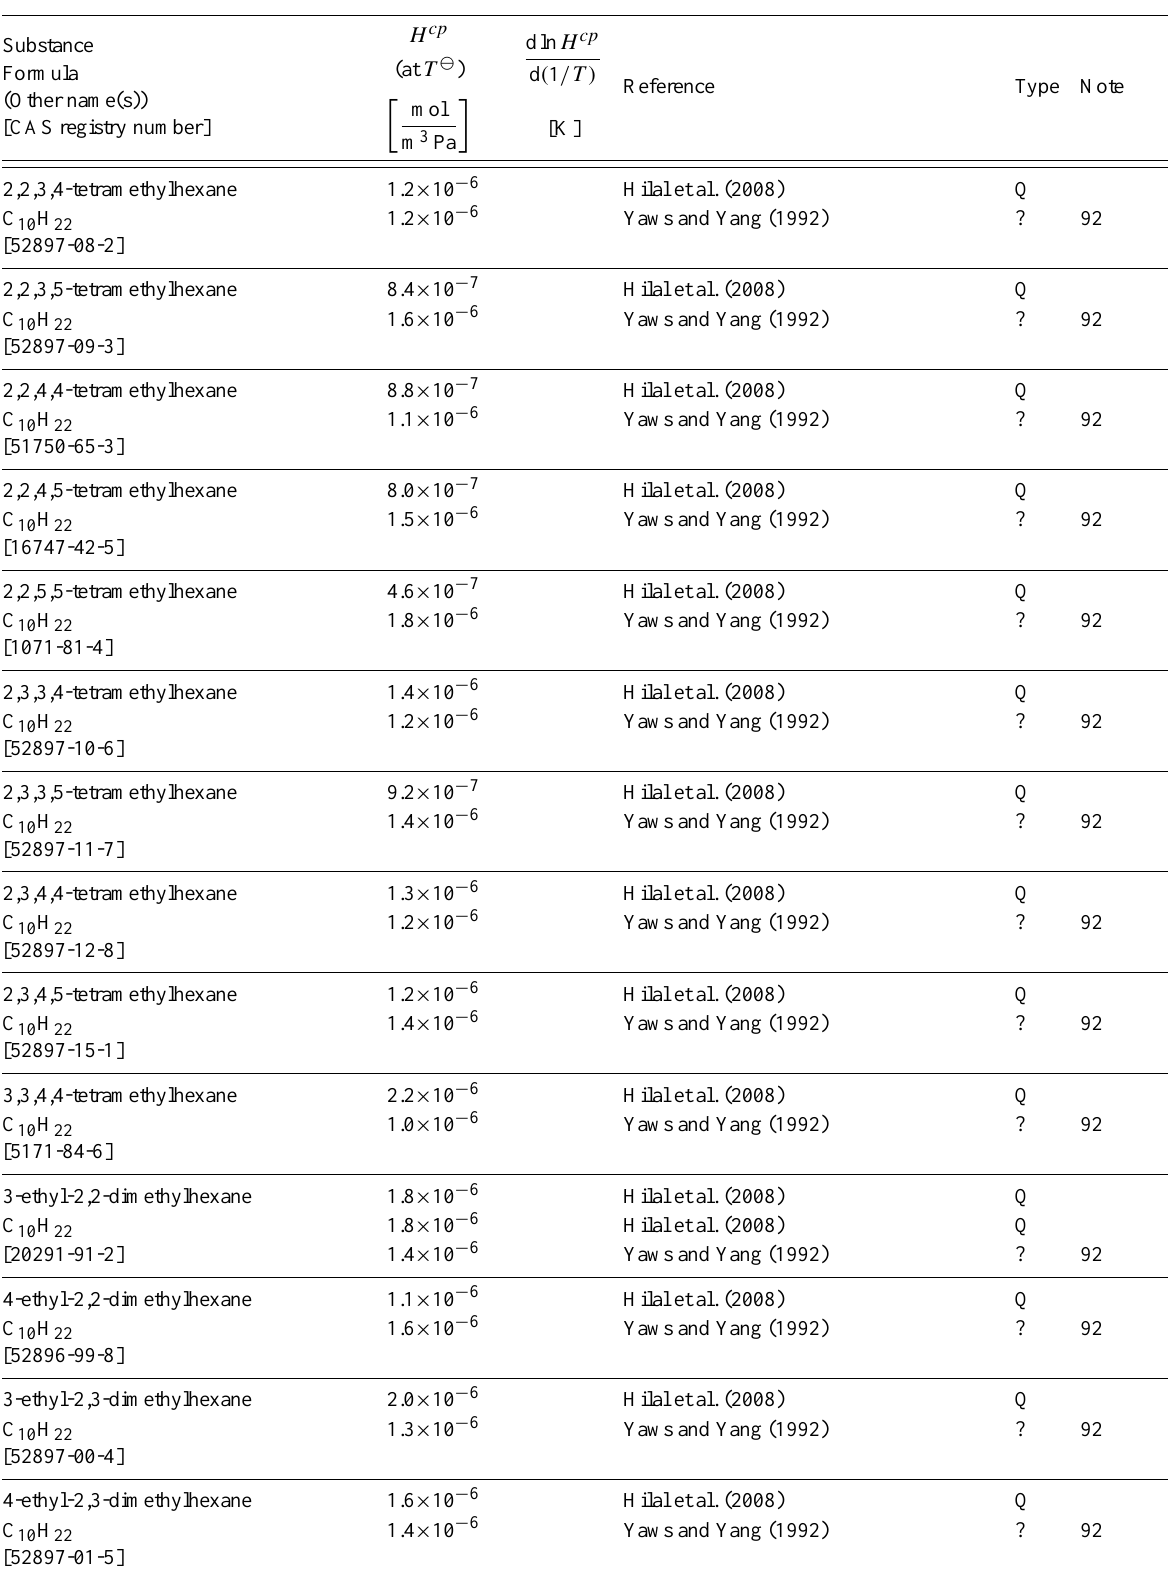
Table 6: Henry’s law constants for water as solvent